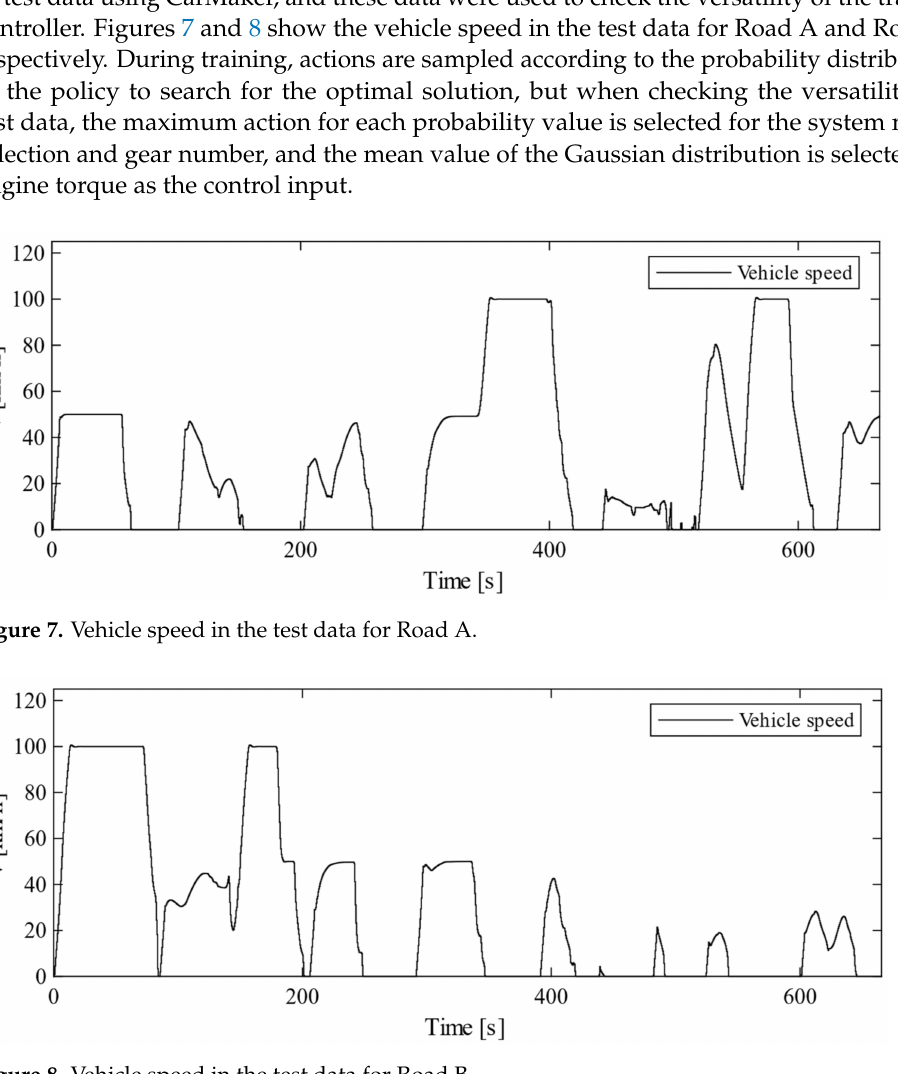
Figure 8. Vehicle speed in the test data for Road